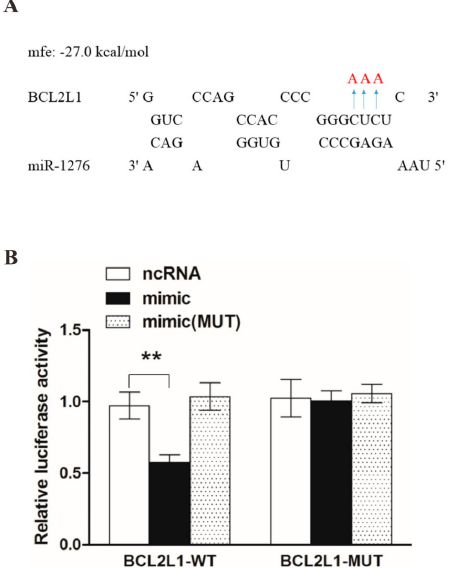
Figure 3. MiR ‐ 1276 targeting the 3 ′ UTR of BCL2L1 mRNA. ( A ) The predicted binding site for miR ‐ 1276 in BCL2L1 3 ′ UTR. In 3 ′ UTR mutant, replaced nucleotide (red) was indicated by the arrows; and ( B ) luciferase activity in HEK293T cells transfected with plasmid encoding wild ‐ type (WT) or mutated (MUT) 3 ′ UTR of human BCL2L1 plus control RNA, mimic miR ‐ 1276, or mimic miR ‐ 1276 (M); ( ** p <